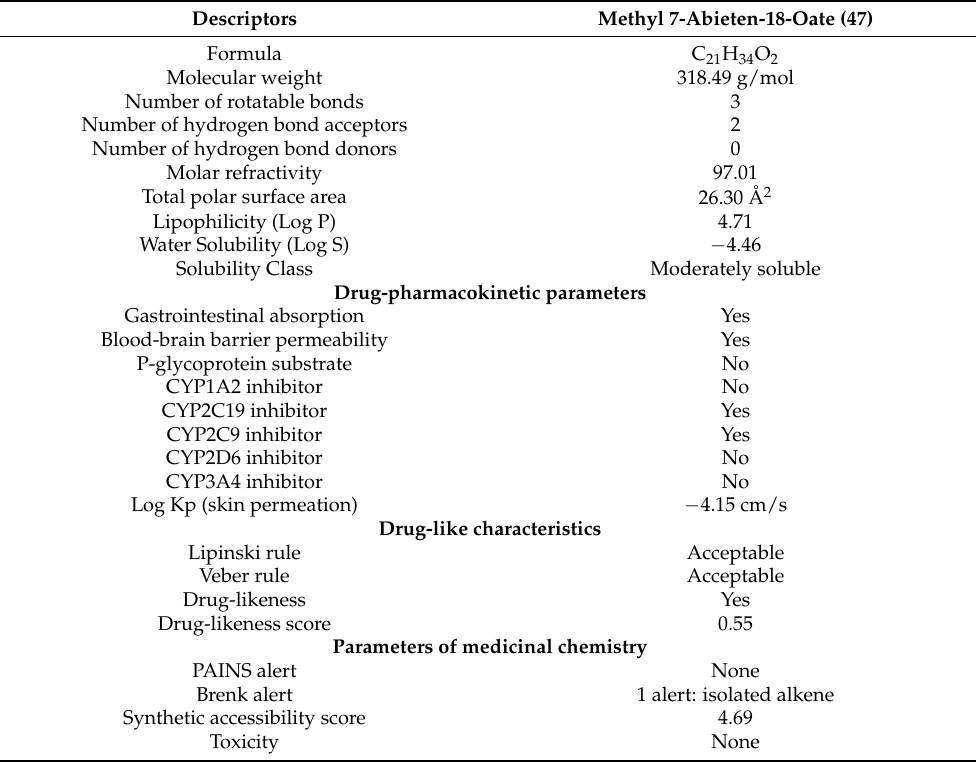
Table 7. Summary of in silico ADMET profile estimated for selected one